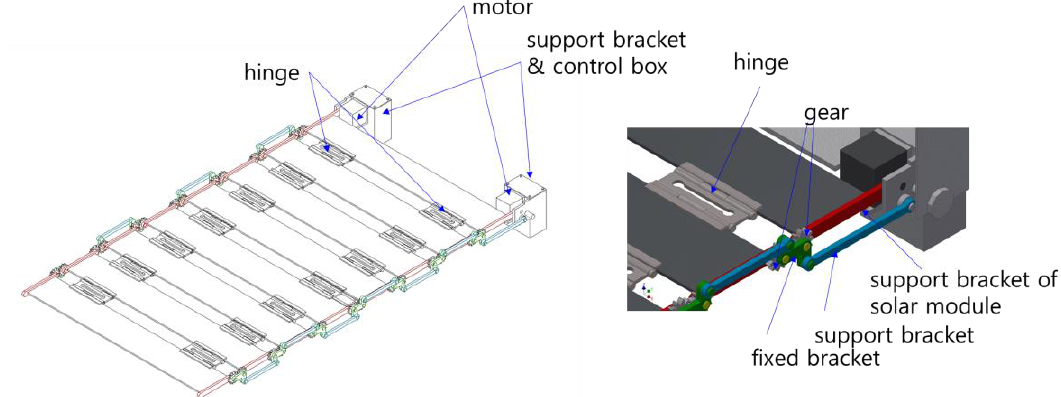
Figure 2. Intelligent solar module design drawing.